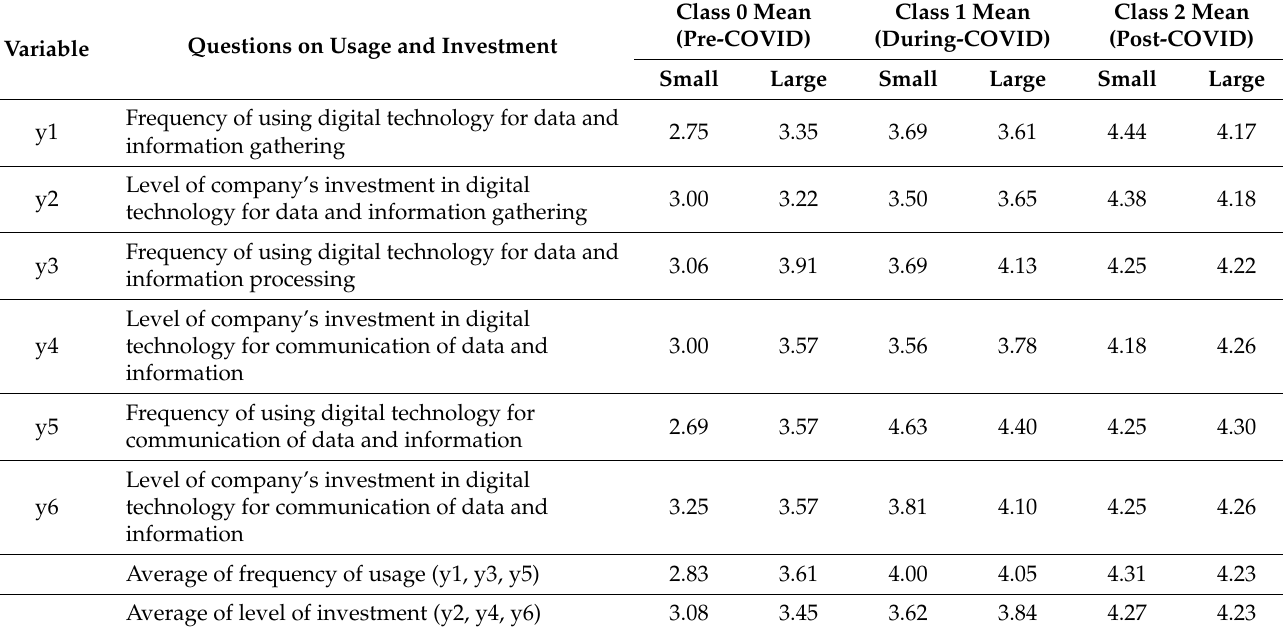
Table 5. Means of the three class populations across small vs. large